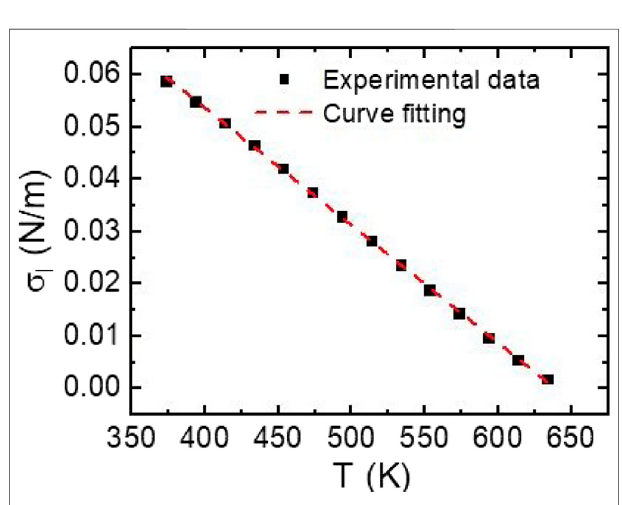
FIGURE 6 | Surface tension of